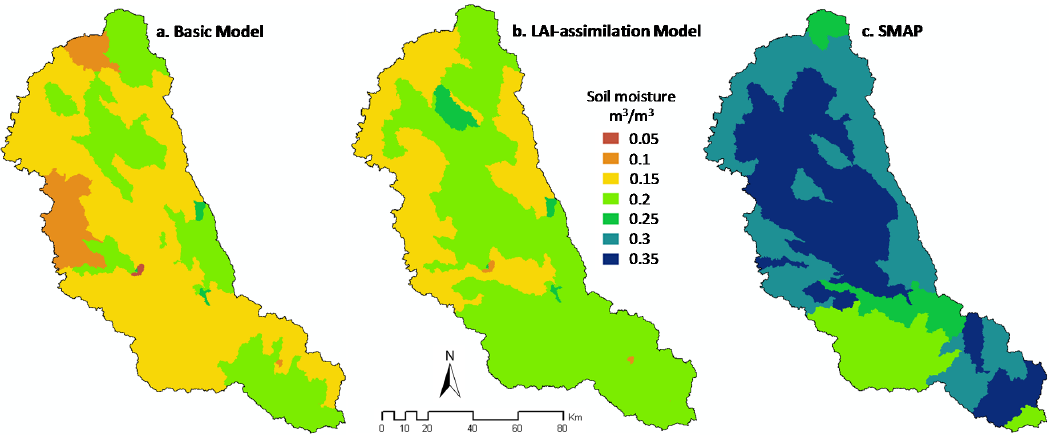
Figure 4. Comparison of daily average rootzone soil moisture across the 2016 crop growing season (June–August): ( a ) Basic model, ( b ) LAI assimilation model, and ( c ) SMAP data. The values represent wetness (m 3 / m 3 ) in the top 100 cm of the soil